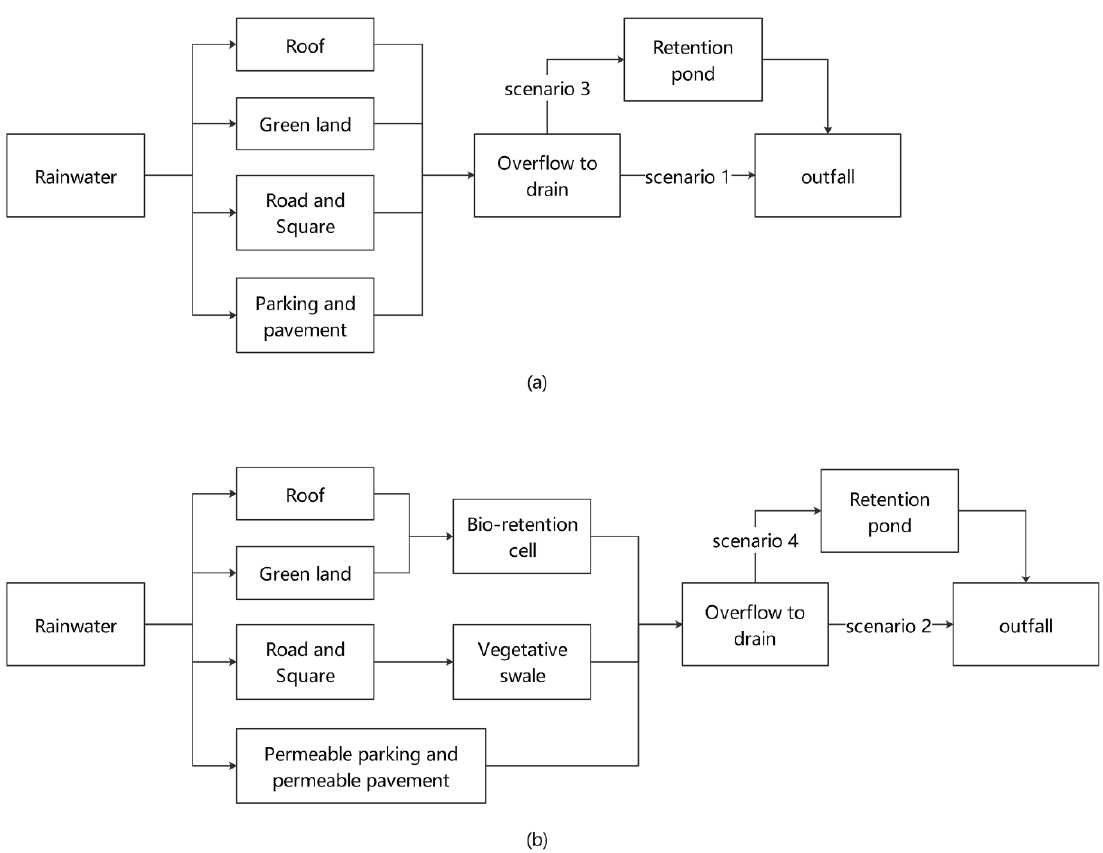
Figure 2. Drainage path in the blocks under different scenarios: ( a ) The drainage path without LID measures; ( b ) The drainage path with LID measures.